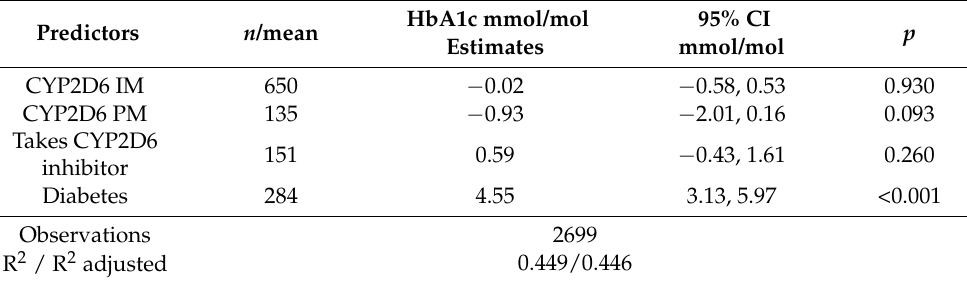
Table 7. Association between CYP2D6 metabolic phenotype and HbA1c levels in participants taking antipsychotics. Model adjusted by age, ethnicity, sex, taking inhibitors of CYP2D6, diabetes status, taking antidiabetics and BMI; Normal metabolizers of CYP2D6 =